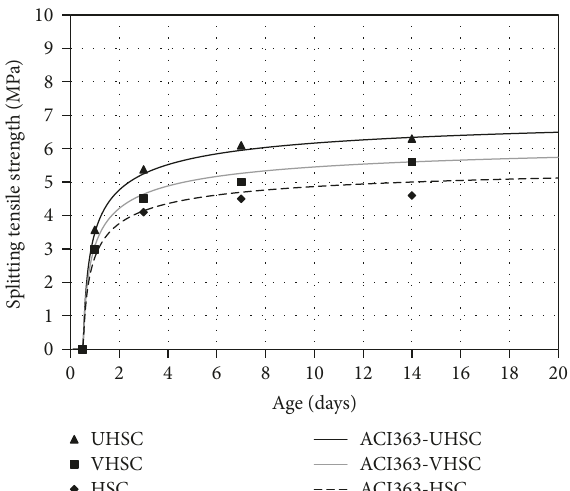
Figure5:Comparisonofsplittingtensilestrengthsoftestresultsand ACI 363R [12].